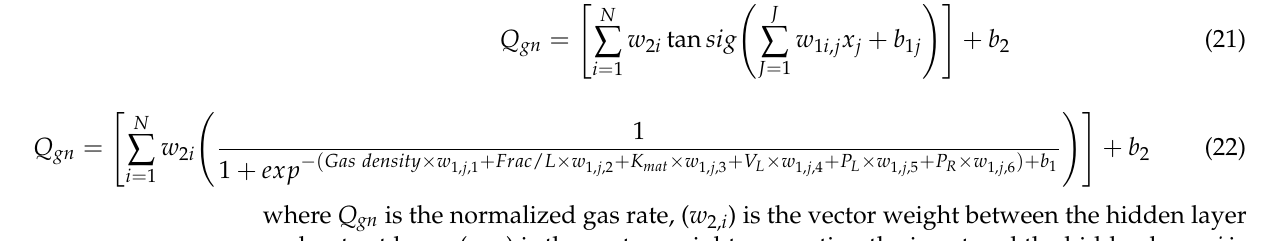
Table 4. Weights and biases for the generated correlation Equation (22).